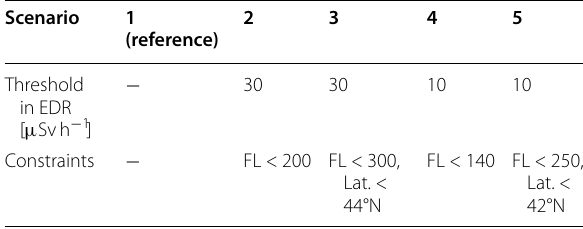
Table 1 Scenarios of flight trajectory